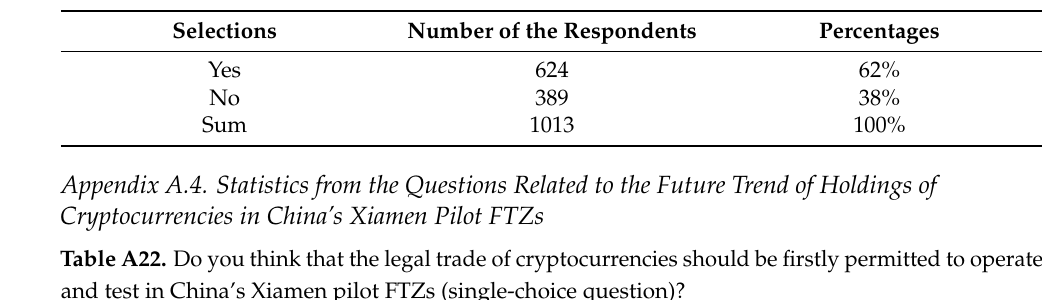
Table A21. Do you think that in China it is essential to set legal exchange platforms of cryptocurrencies and enhance platforms’ management (single-choice question)?